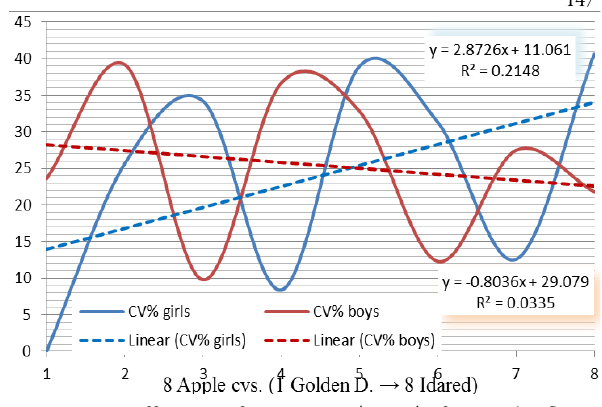
Fig. 11. Coefficient of variation (CV%) for apple flavor, evaluated by 1-5 scale (Q1), presented by gender (50% male, 50%